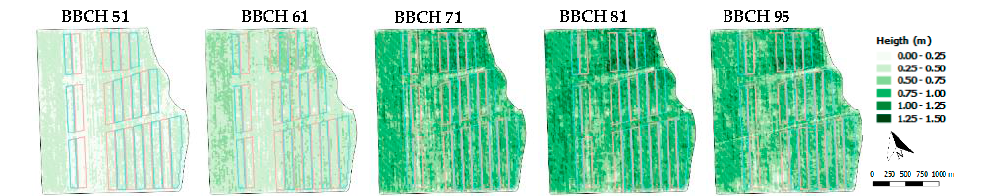
Figure 9. Spatial distribution of crop height in five phenological stages of conventional row spacing cotton in field CF3.